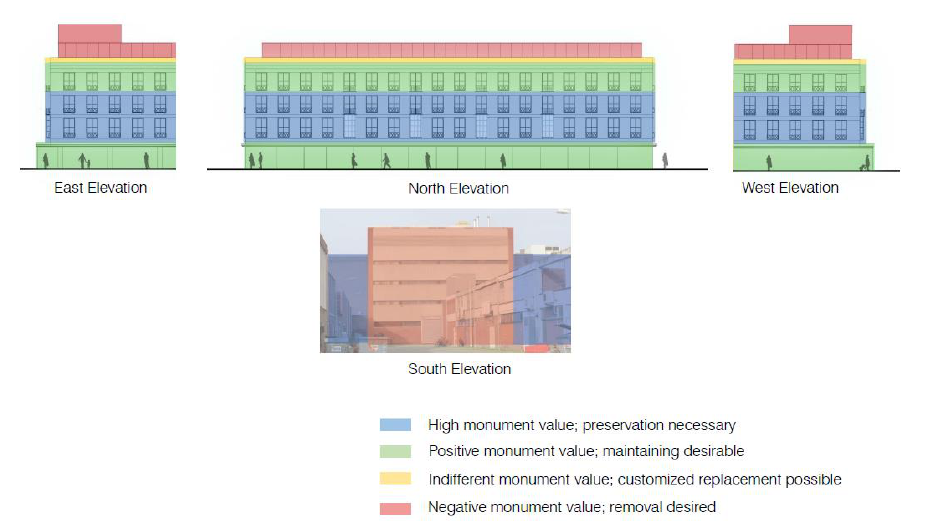
Fig 10. 18 Septemberplein section showing degrees of monumental value ©UNStudio.